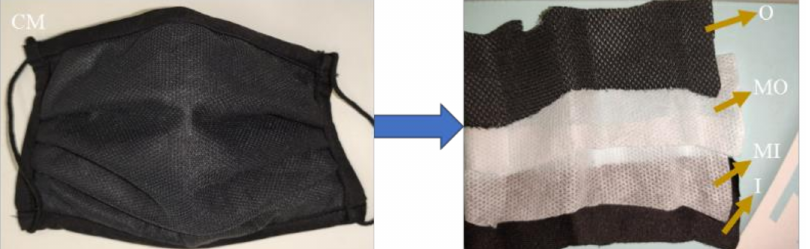
Figure 1. Images of the studied RPD. Top: surgical masks ( SM ); Middle: KN95 masks ( KN ); and Bottom: cloth masks ( CM ). RPD constituent layers: outer layer (O), inner layer (I), and intermediate layer (M). For CM-type masks, the existing intermediate layers were indicated as intermediate layers close to the outer layer (MO) and as intermediate layer close to the inner layer